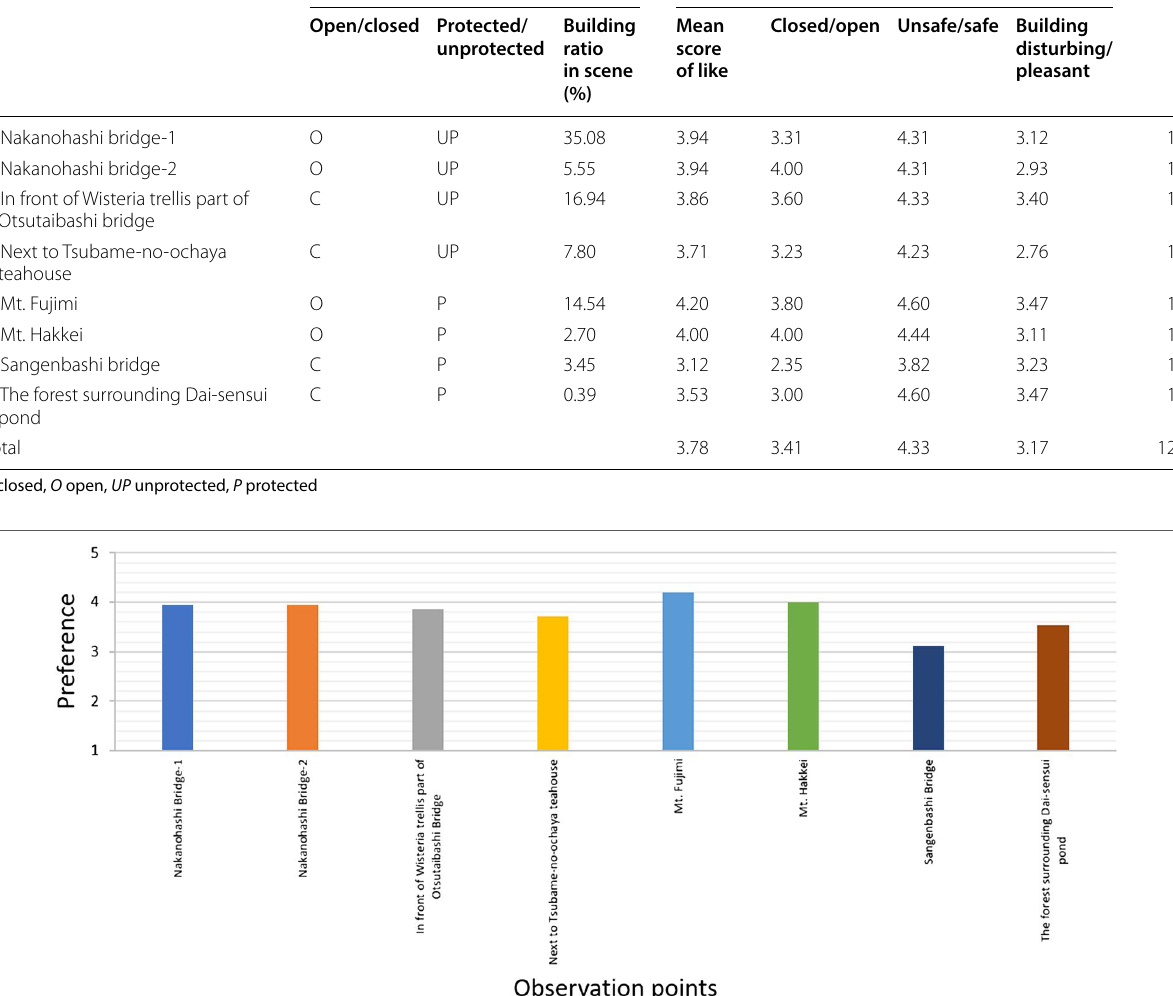
Table 3 Mean scores of the sites Name of the site